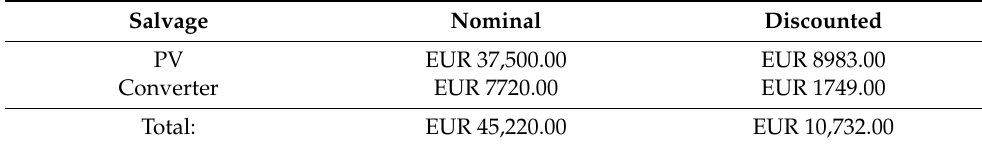
Table 10. Salvage value of PV and converter at the end of lifetime of the project.